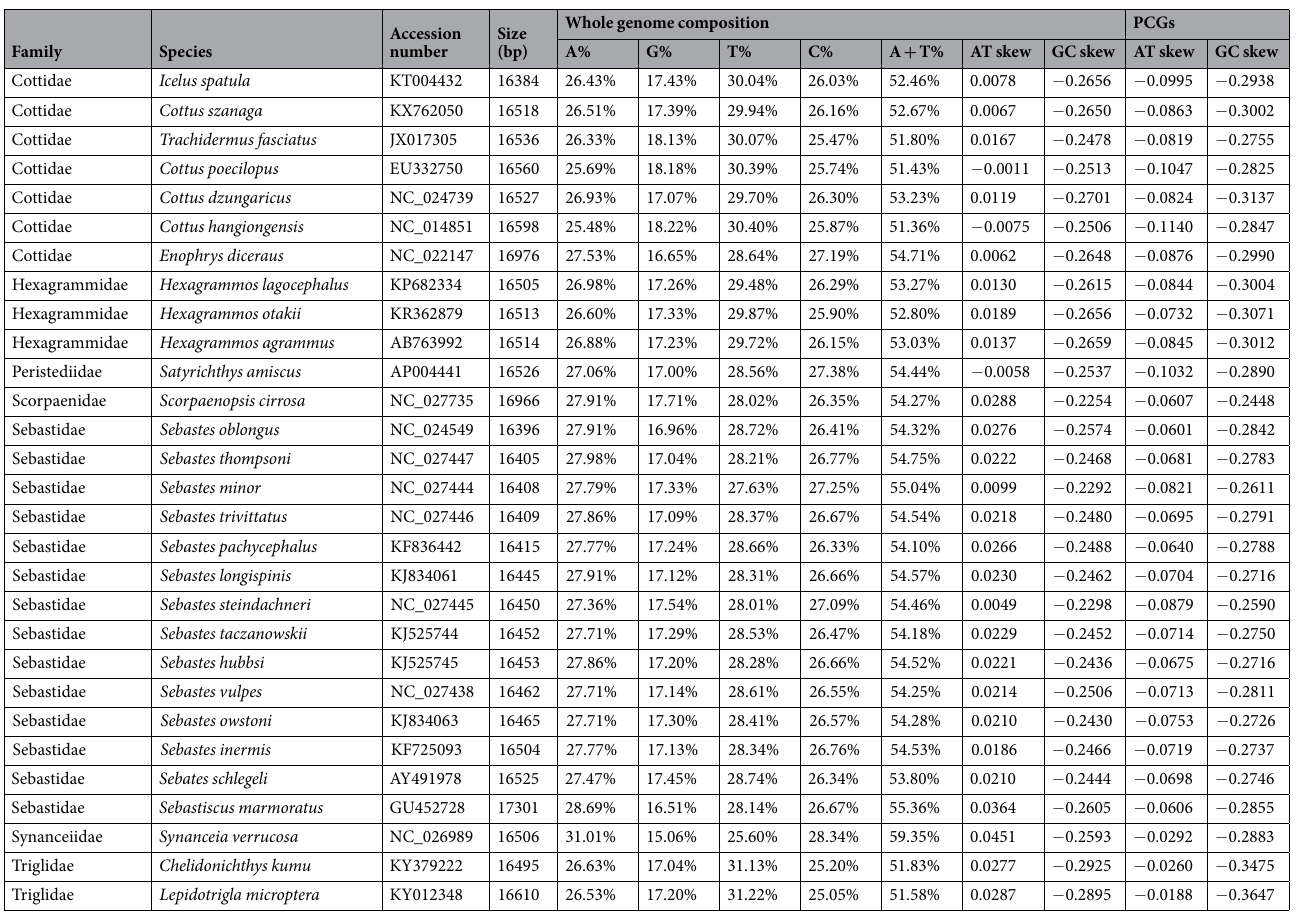
Table 1. List of the complete mitogenomes of Scorpaeniformes fish. Complete mitogenomes and PCGs composition bias of all Scorpaeniformes fish mitogenomes available from GenBank. The accession numbers and the size of mitogenomes are